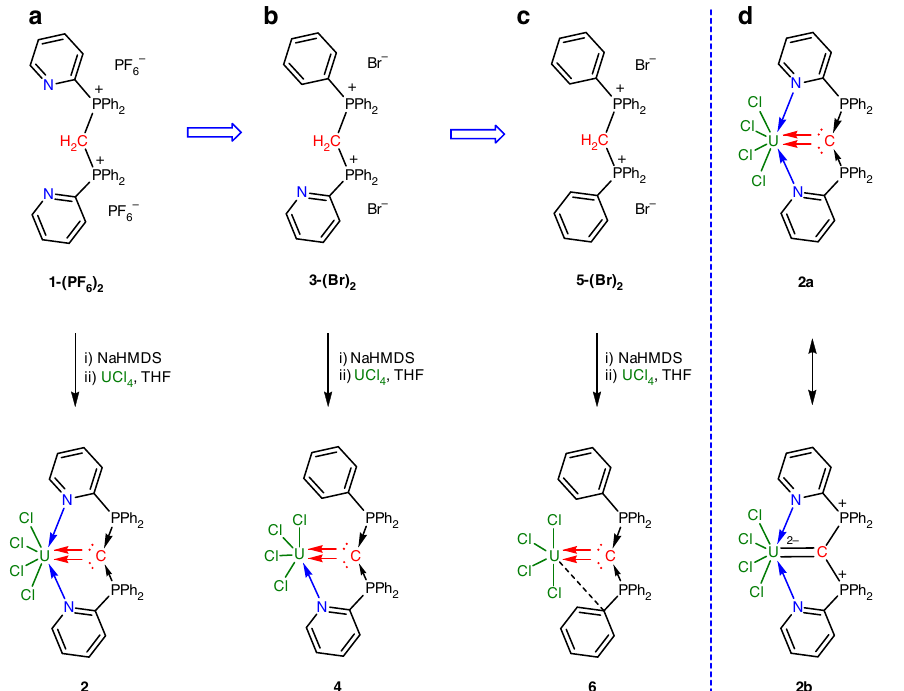
Fig. 1 Synthesis of CDP-UCl 4 adducts. Synthesis of double dative bond adducts 2 ( a ), 4 ( b ), and 6 ( c ) employ tridentate, bidentate, and monodentate CDP precursors 1-(PF 6 ) 2 , 3-(Br) 2 , and 5-(Br) 2 , respectively. d Two major resonance structures of complex 2 with a double dative bond ( 2a ) and with an electron-sharing U = C double bond ( 2b